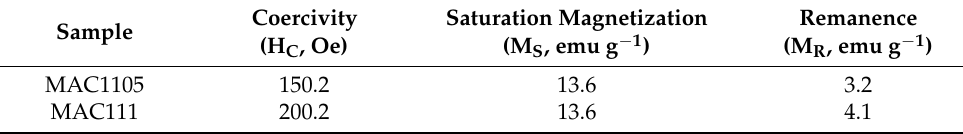
Figure 6. M-H hysteresis loops of MAC1105 and MAC111 at room temperature. The inset is a magnified view of the M-H curves. Table 2. Magnetic properties of the magnetic activated